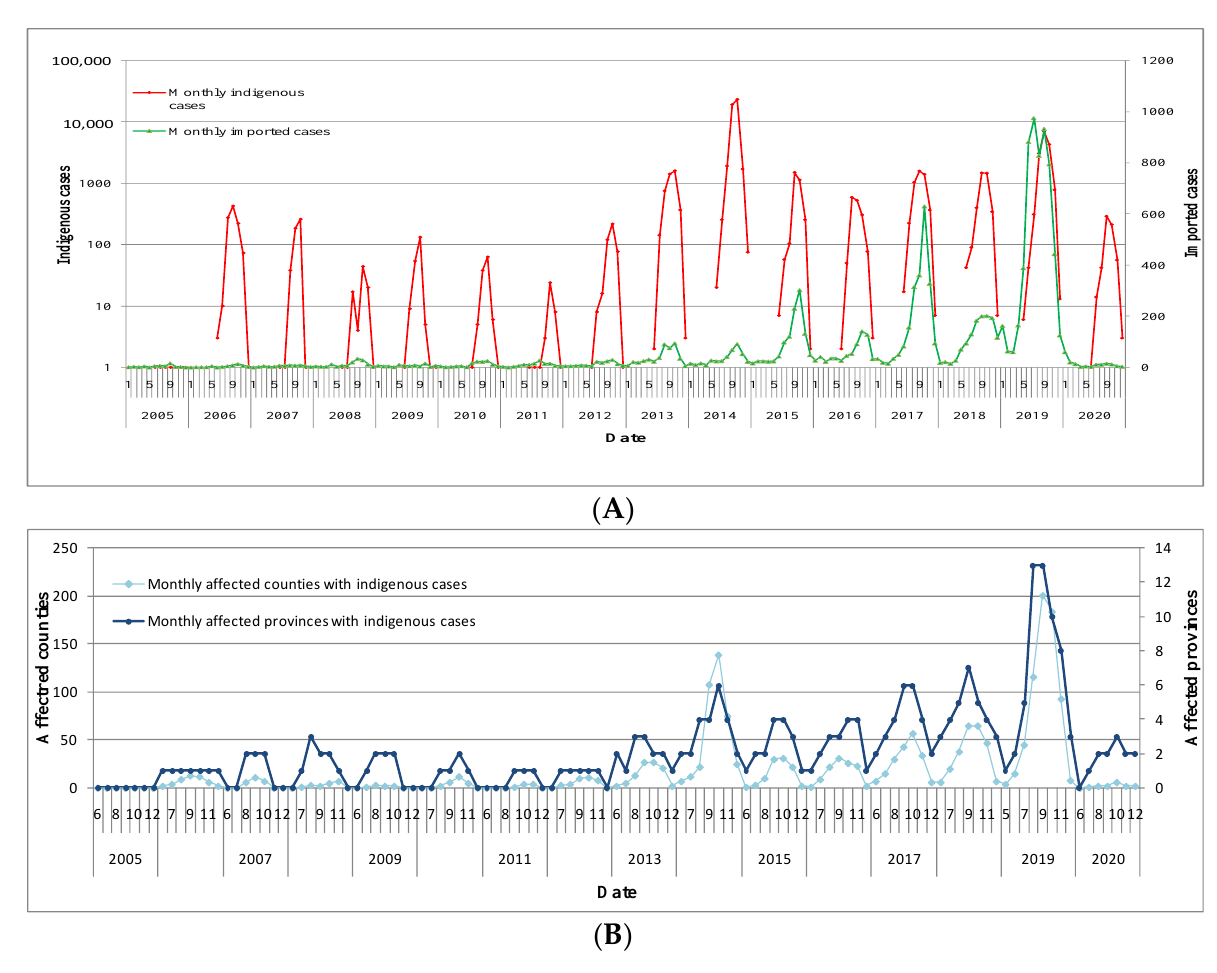
Figure 2. Time-series analyses of dengue cases from 2005 to 2020. ( A ) Monthly imported dengue cases from January to December 2005–2020, and monthly indigenous dengue cases from June to December 2005–2020, and in May 2019. ( B ) Monthly affected counties and provinces with indigenous cases from June to December 2005–2020, and in May